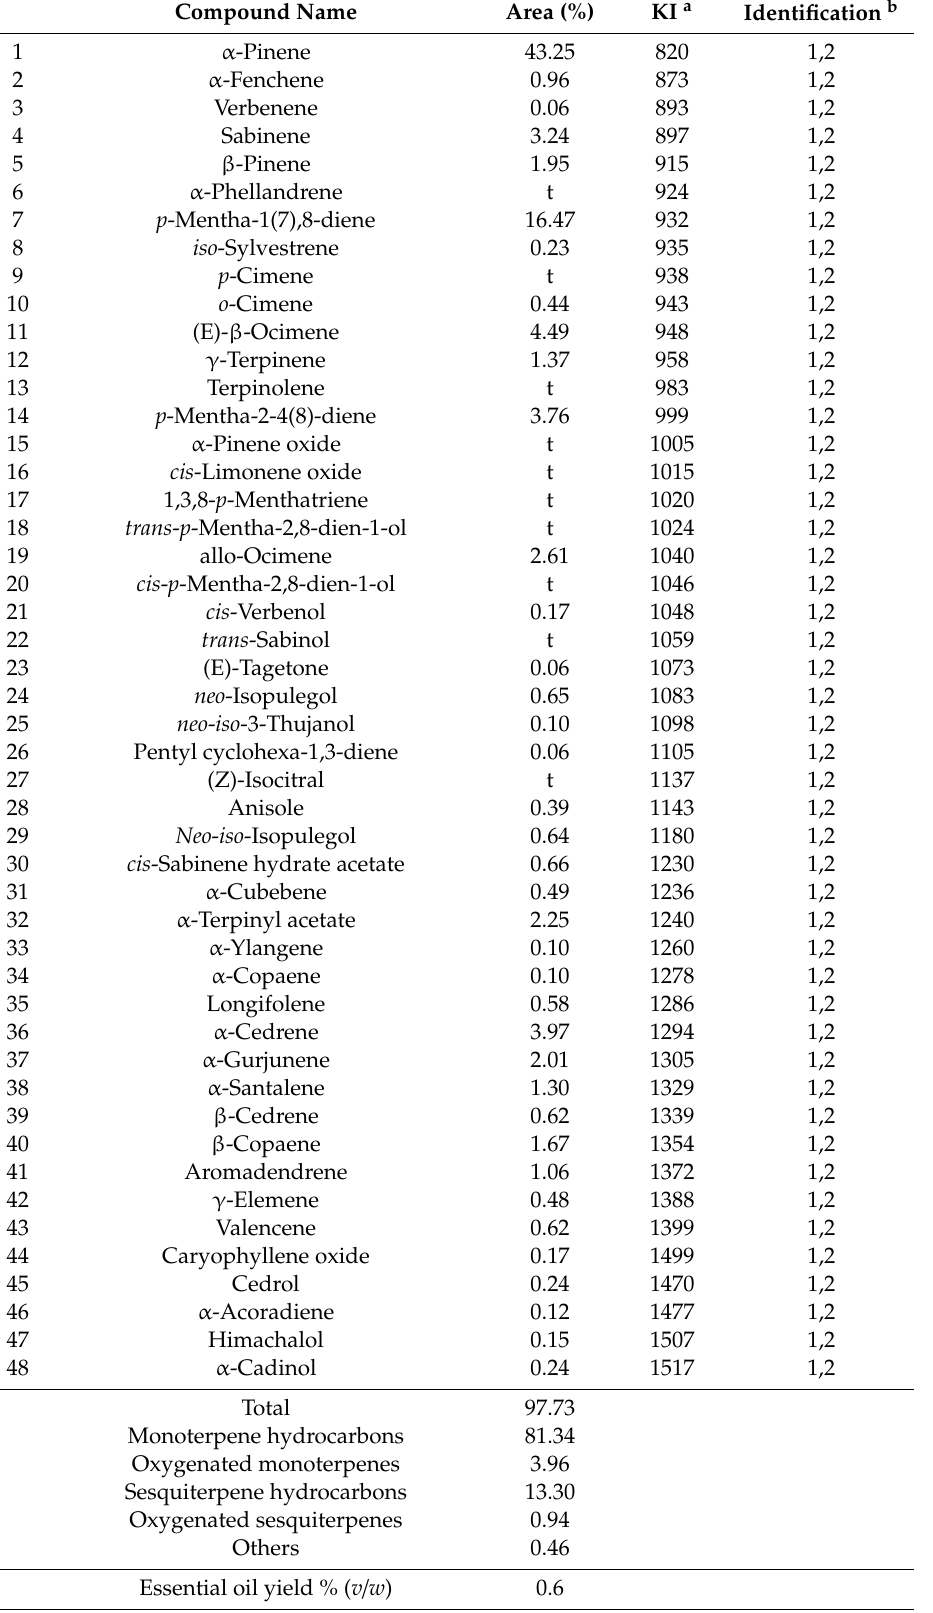
Table 4. Chemical composition of EO from C. sempervirens L.